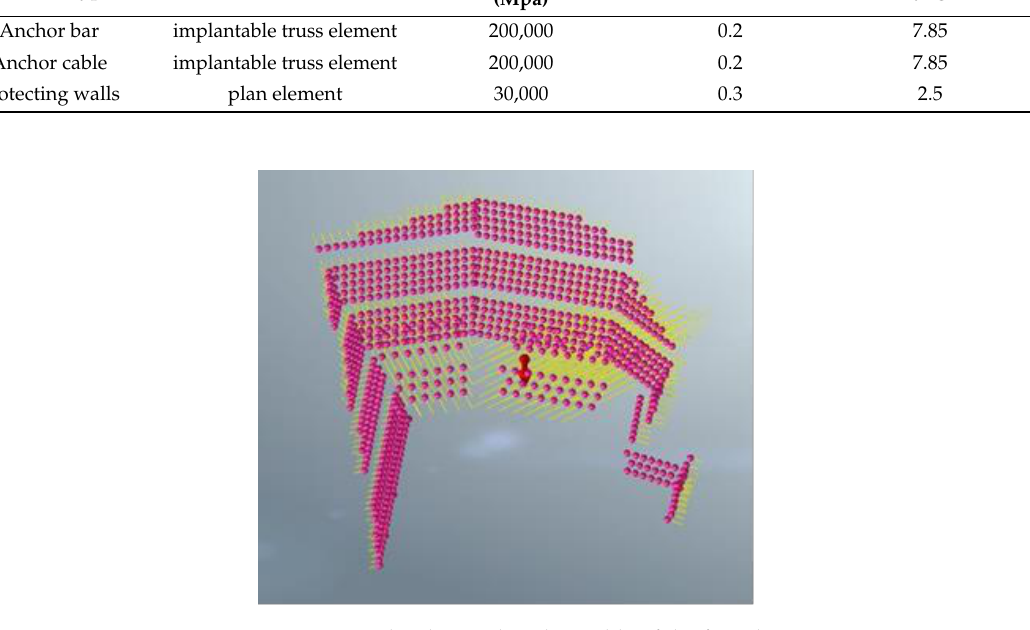
Figure 6. Anchor bar and anchor cable of the foundation pit system.